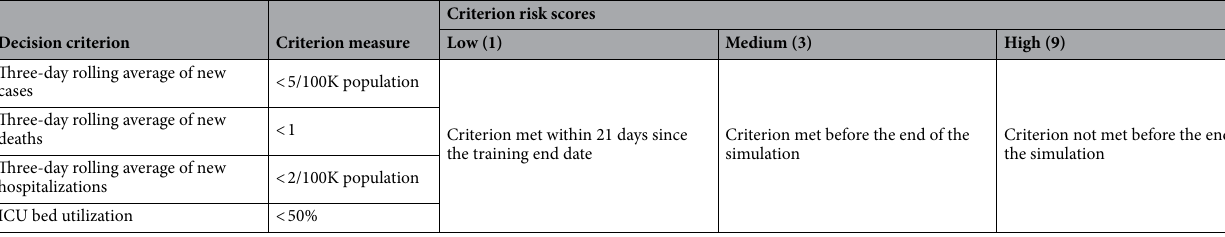
Table 2. Decision criteria, measures, and risk scores for ranking individual counties in each